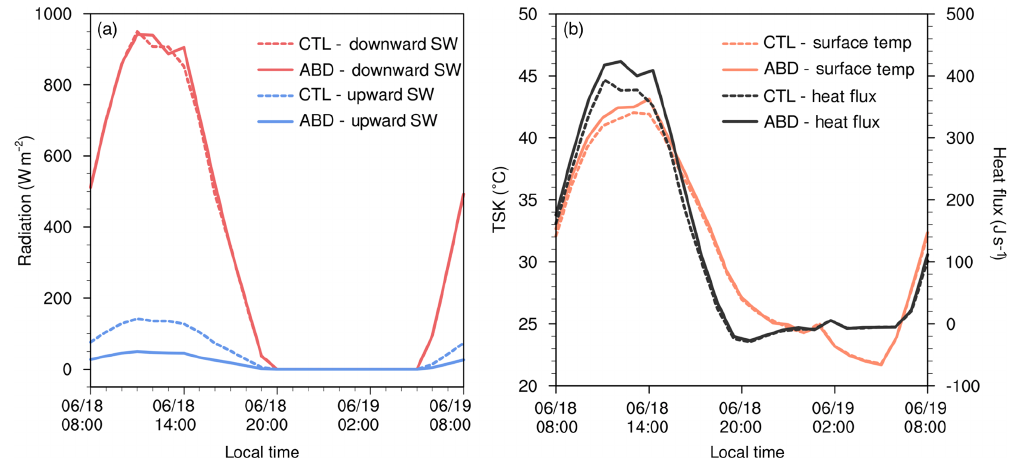
Figure 9. Thermal physical quantities at surface level on 18 June 2012 in experiments CTL and ABD. (a) Downward and upward shortwave radiation. (b) Surface temperature and upward heat flux.